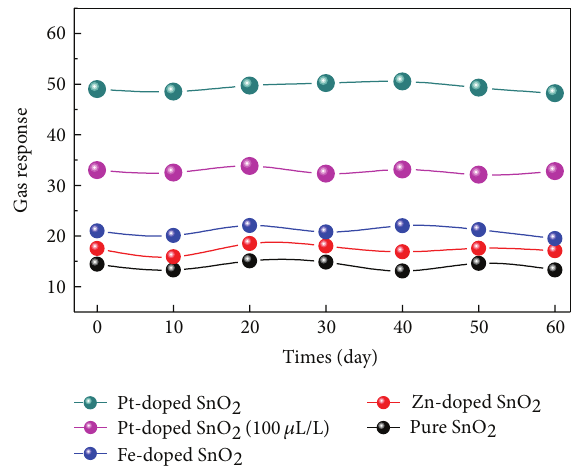
Figure 4: Gas responses of the sensors to 100ppm of CO at various operating temperatures.